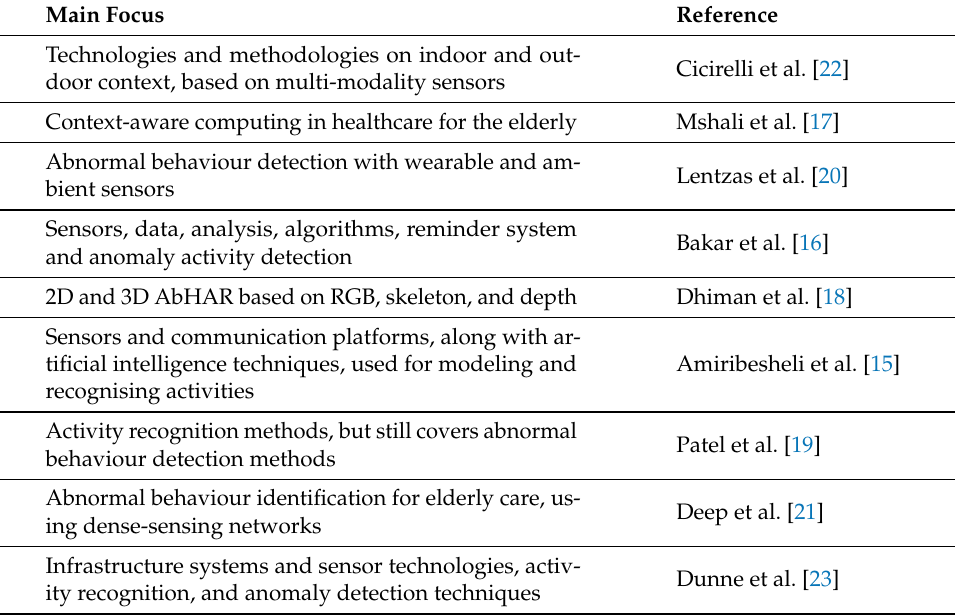
Table 1. Related surveys on abnormal behaviour